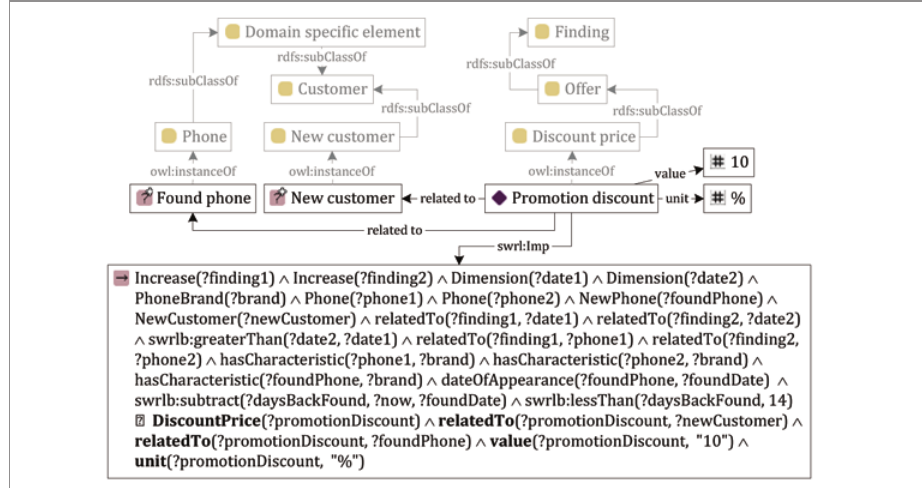
Fig. 6. Constraint presented in ontology in SWRL and OWL syntax